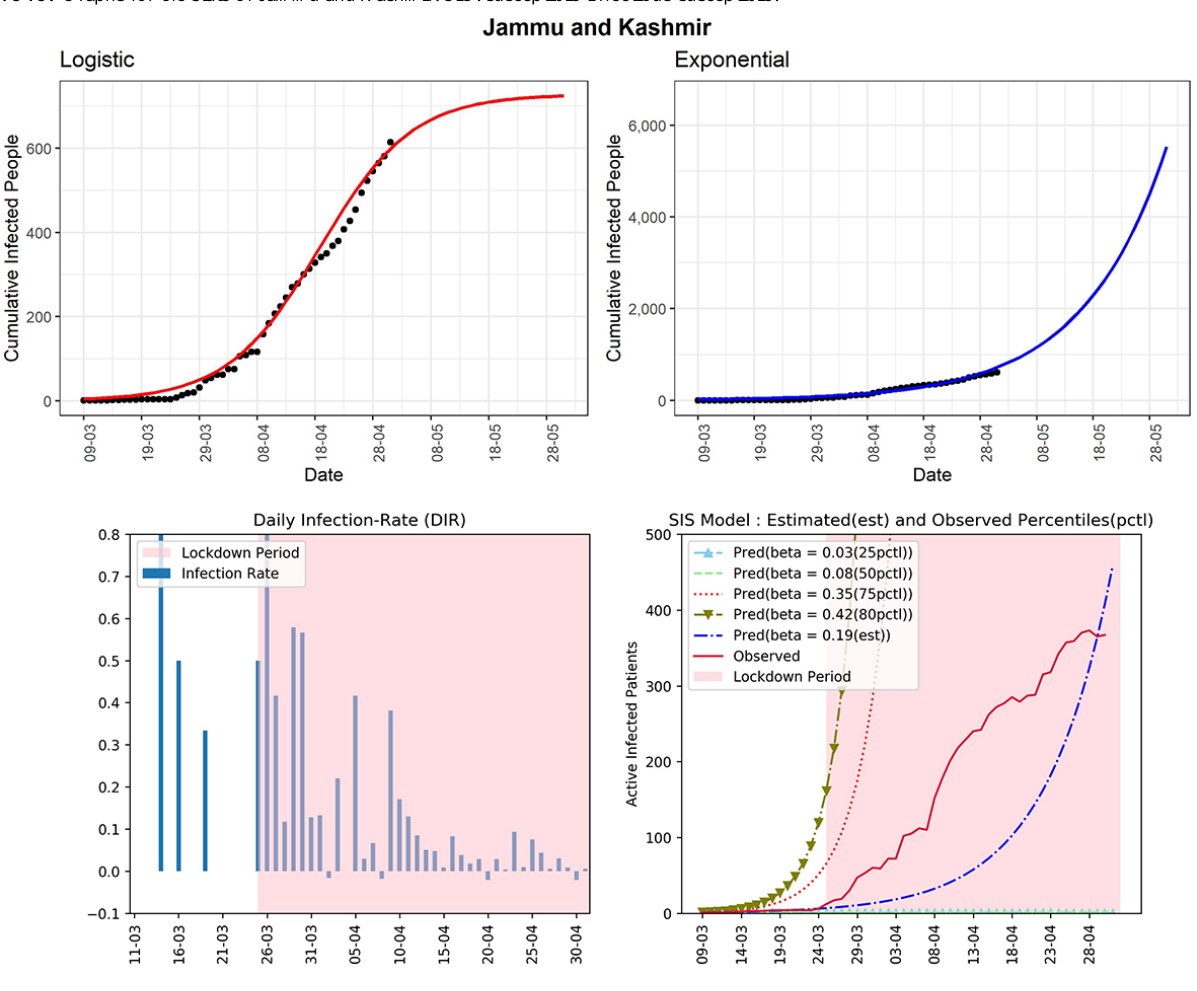
Figure 15. Graphs for the state of Jammu and Kashmir. SIS: susceptible-infectious-susceptible.